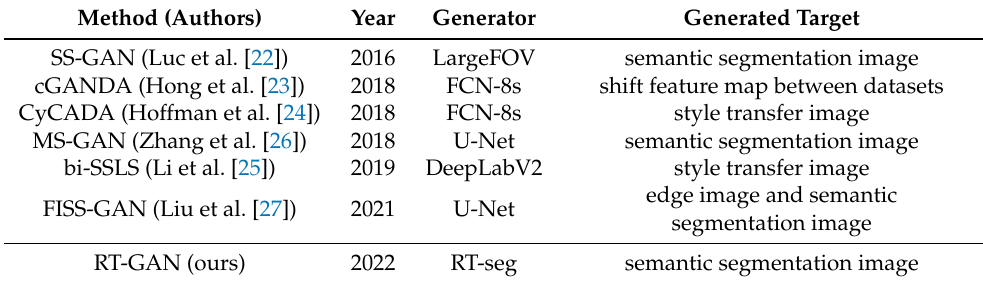
Table 1. Characteristics of state-of-the-art GAN-based semantic segmentation